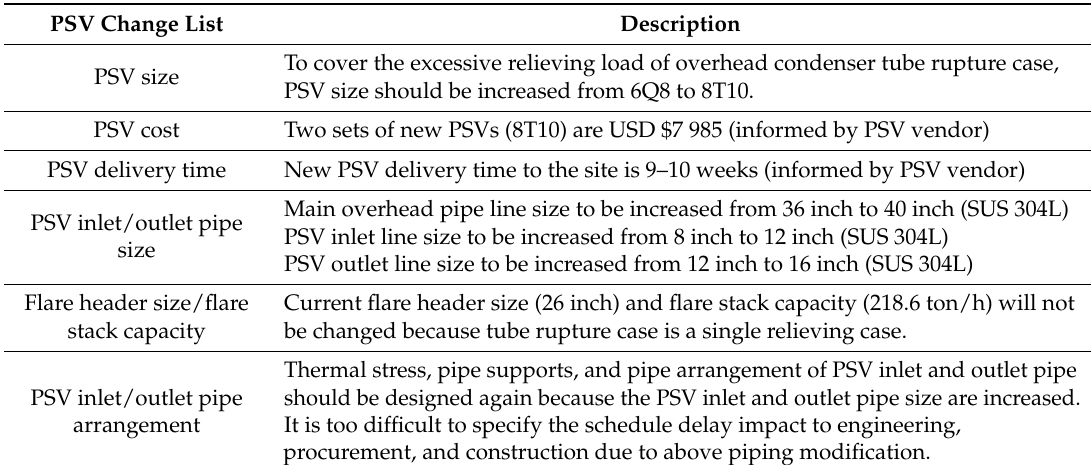
Table 8. Description of the pressure safety valve (PSV) change